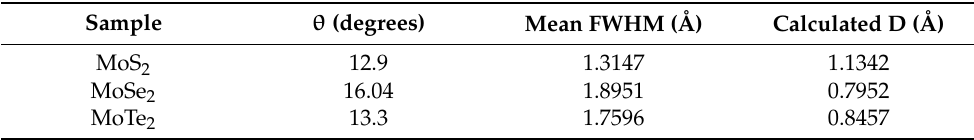
Table 2. XRD parameters and the calculated mean sizes for the nanomaterials .